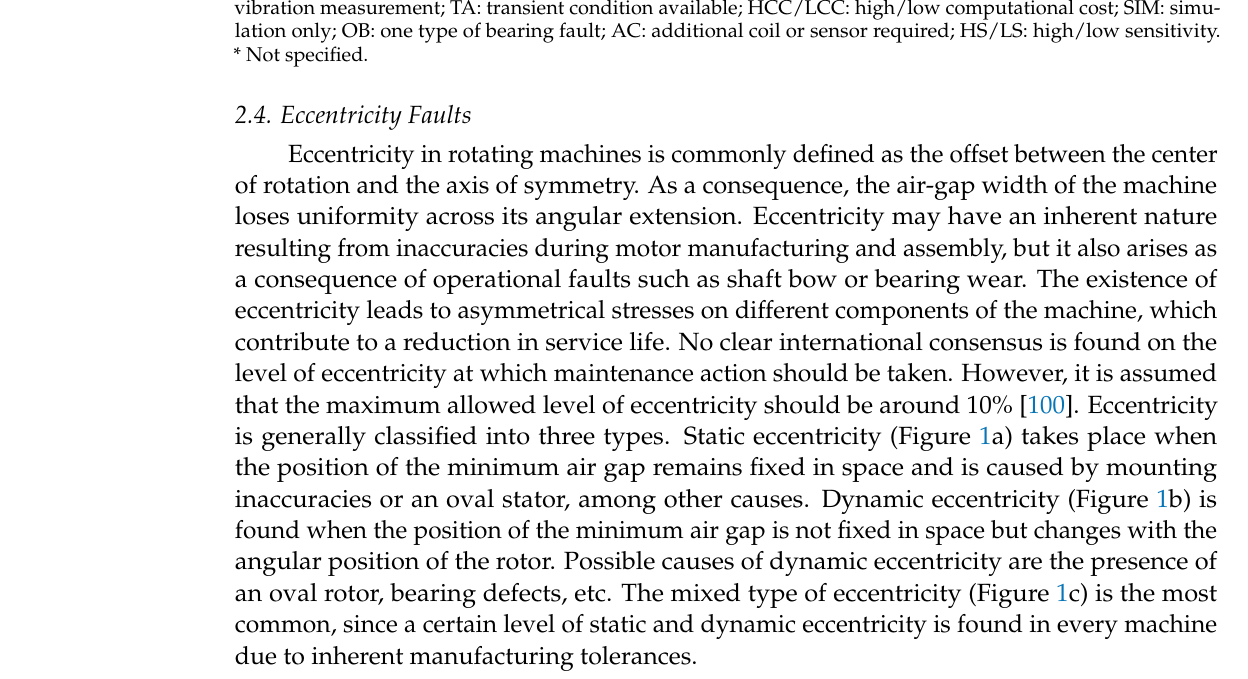
where 𝑘 = 0, 1, 2, 3 … .